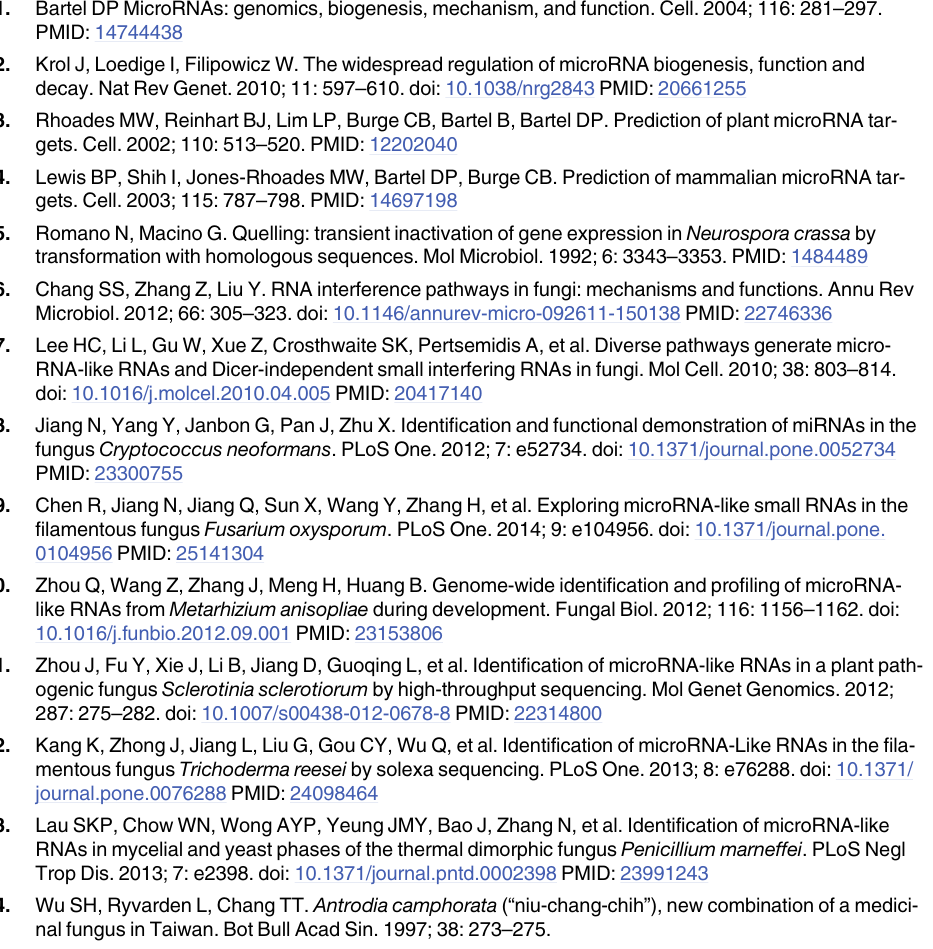
S2 Fig. Secondary hairpin structures of conserved miRNA from A . cinnamomea predicted by RNAfold. (TIF) S3 Fig. Alignment of the milRNAs and the related target genes. (TIF) S1 Table. Annotation of specify contigs after DEGs analysis. S2 Table. milRNAs distribution on A . cinnamomea S28